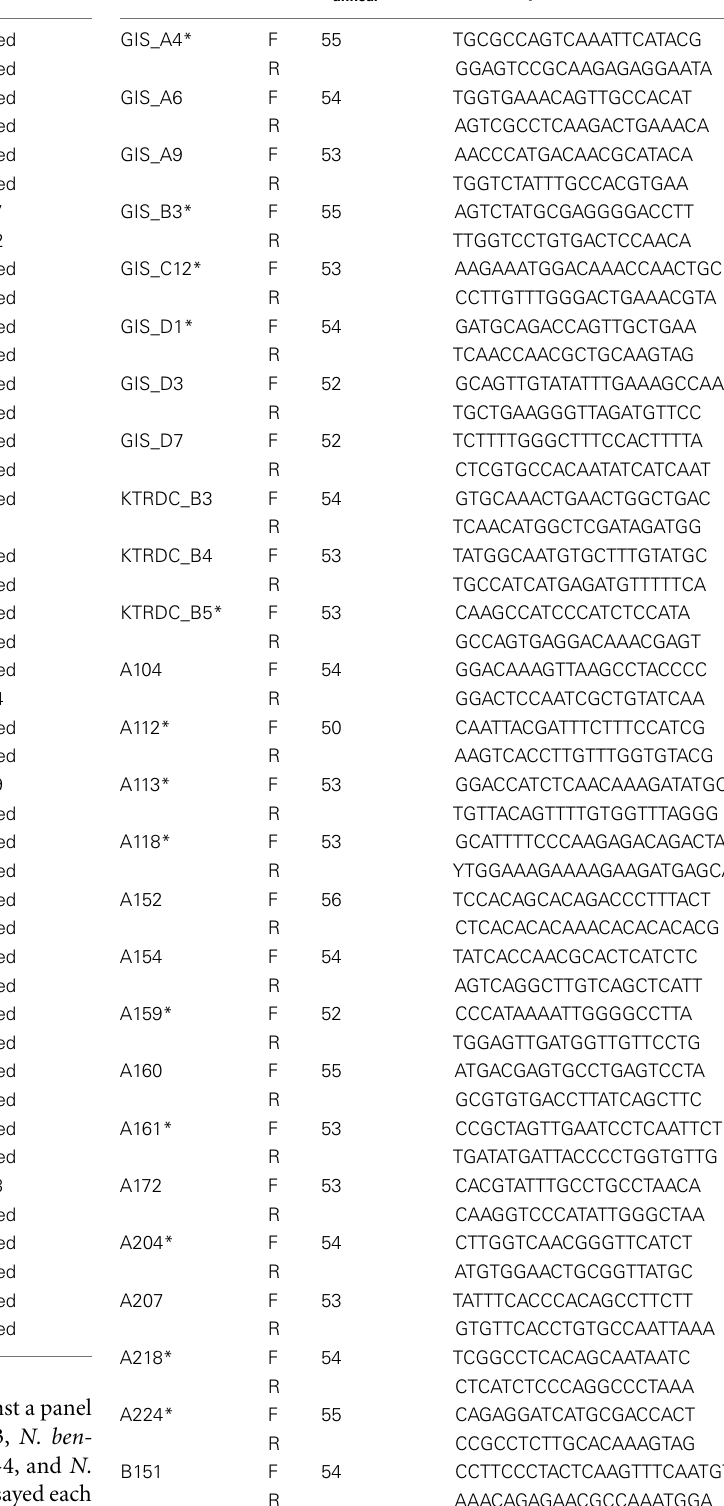
Table 2 |AFLP primer pairs used in BSA screening for linkage to the R-gene NlRPT .